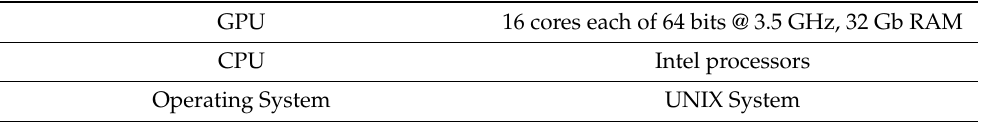
Table 6. The Sun station configuration.